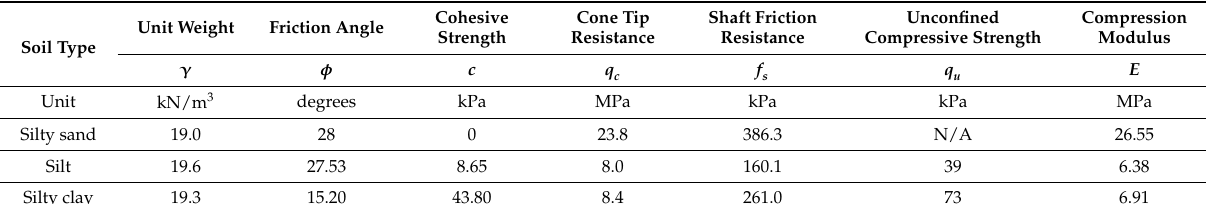
Table 1. Parameters of three typical soils.